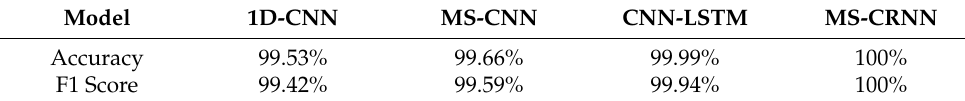
Table 5. Results of the experiment in original CWRU data condition.